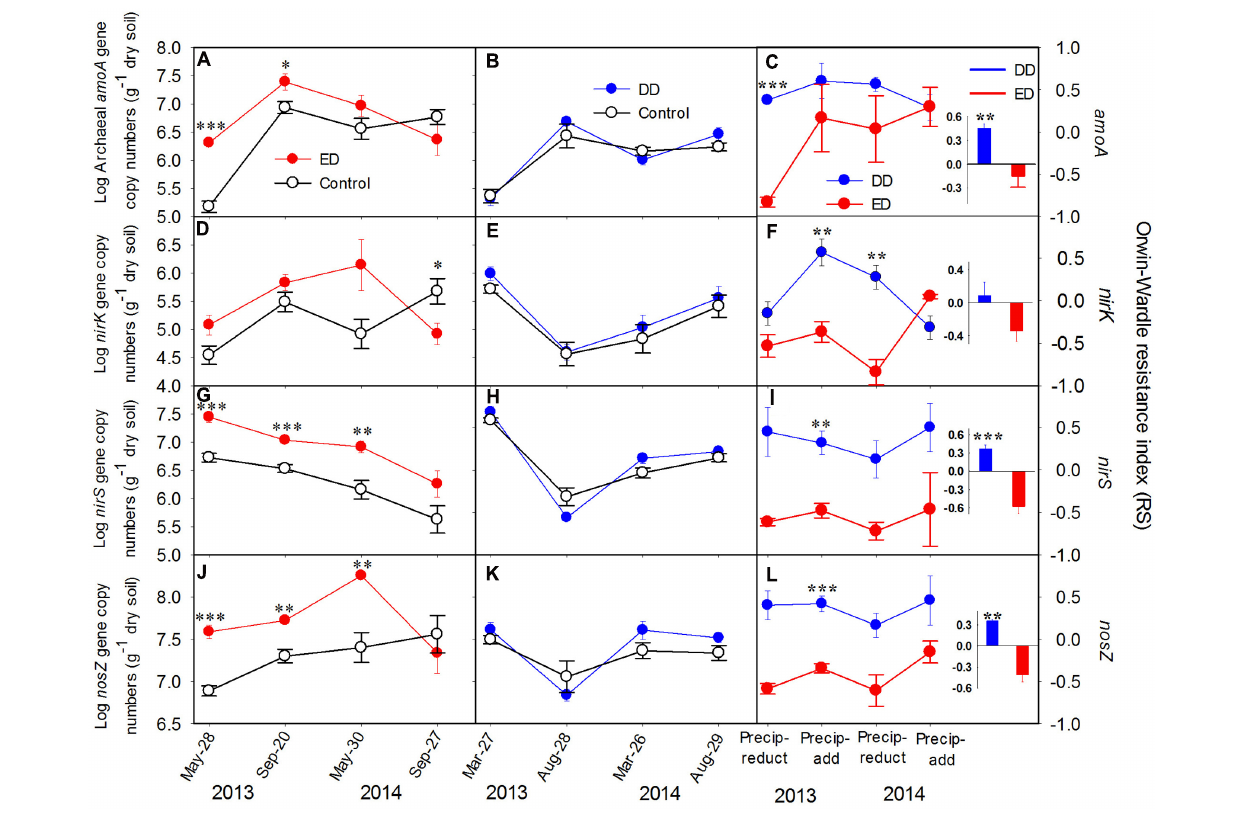
FIGURE 2 | Log-transformed copy numbers of (A–C) archaeal amoA , (D–F) nirK , (G–I) nirS and (J–L) nosZ genes in the control and treatment plots, and their resistance indices throughout the experiment ( n = 4). The insert bar charts represent the average values of the resistance index in each treatment during the experiment. The y -axis of the middle and left panels is presented on the left side, and the y -axis of the right panel is presented on the right side. The significance of the difference between the treatments and control at each sampling point is presented as ∗∗∗ p < 0.001, ∗∗ p < 0.01, ∗ p < 0.05. Abbreviations: DD, dryer dry season and wetter wet season; ED, extending dry season and wetter wet season; Precip-reduct, precipitation reduction; Precip-add, precipitation